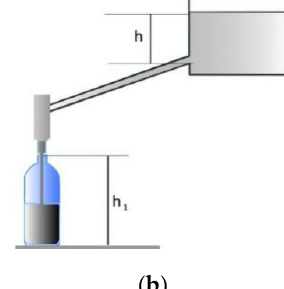
Figure 7. System parameters varied during the tests ( ℎ and ℎ 1 ). ( a ) Parameters highlighted on a weight filler station. ( b ) Schematic representation of a station.